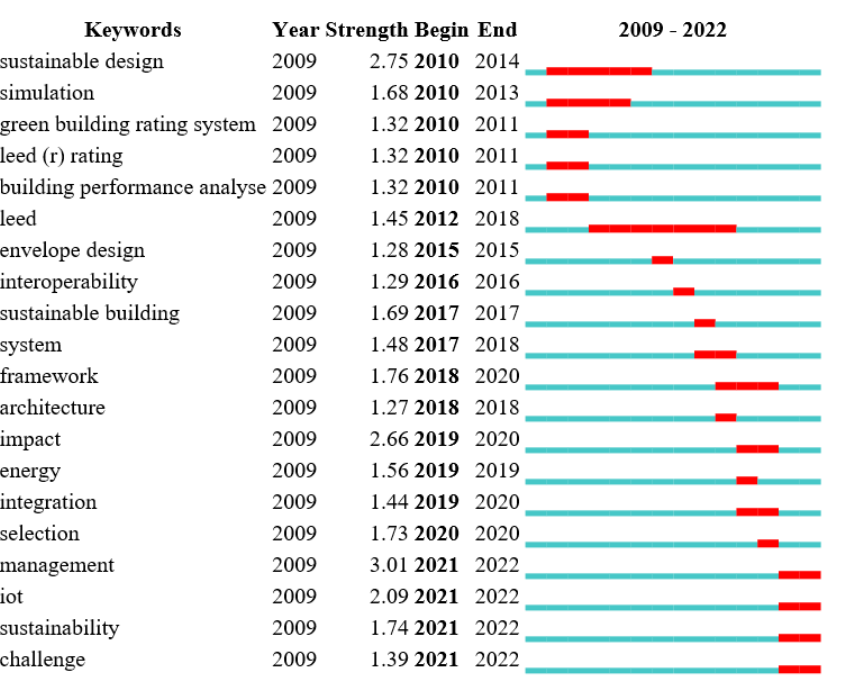
Figure 6. Top 20 emergent words in the field of BIM–IoT-sustainable building via Citespace (generated by the authors).